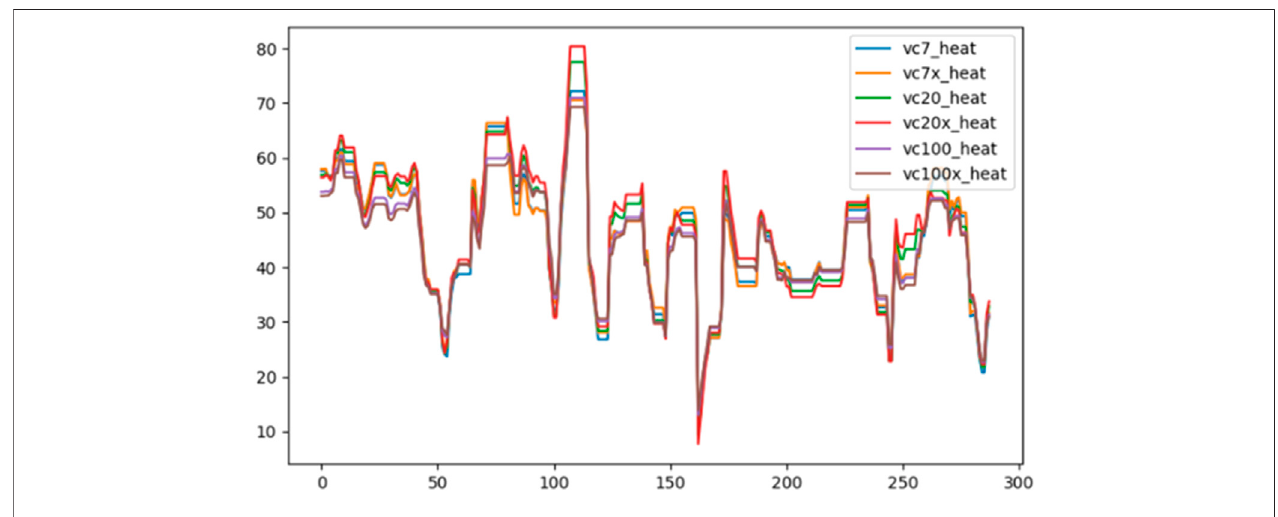
FIGURE 7 | Comparison of six trading popularity indices on August 3, 2021.